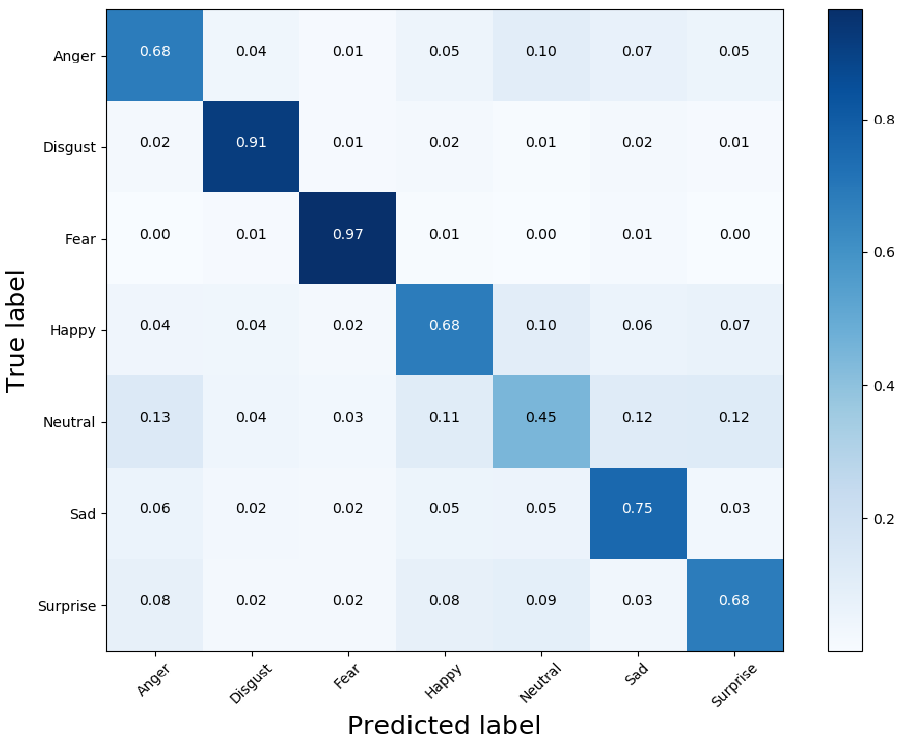
Figure 9. The confusion matrix of CAER-Net-S on CAER-S dataset.